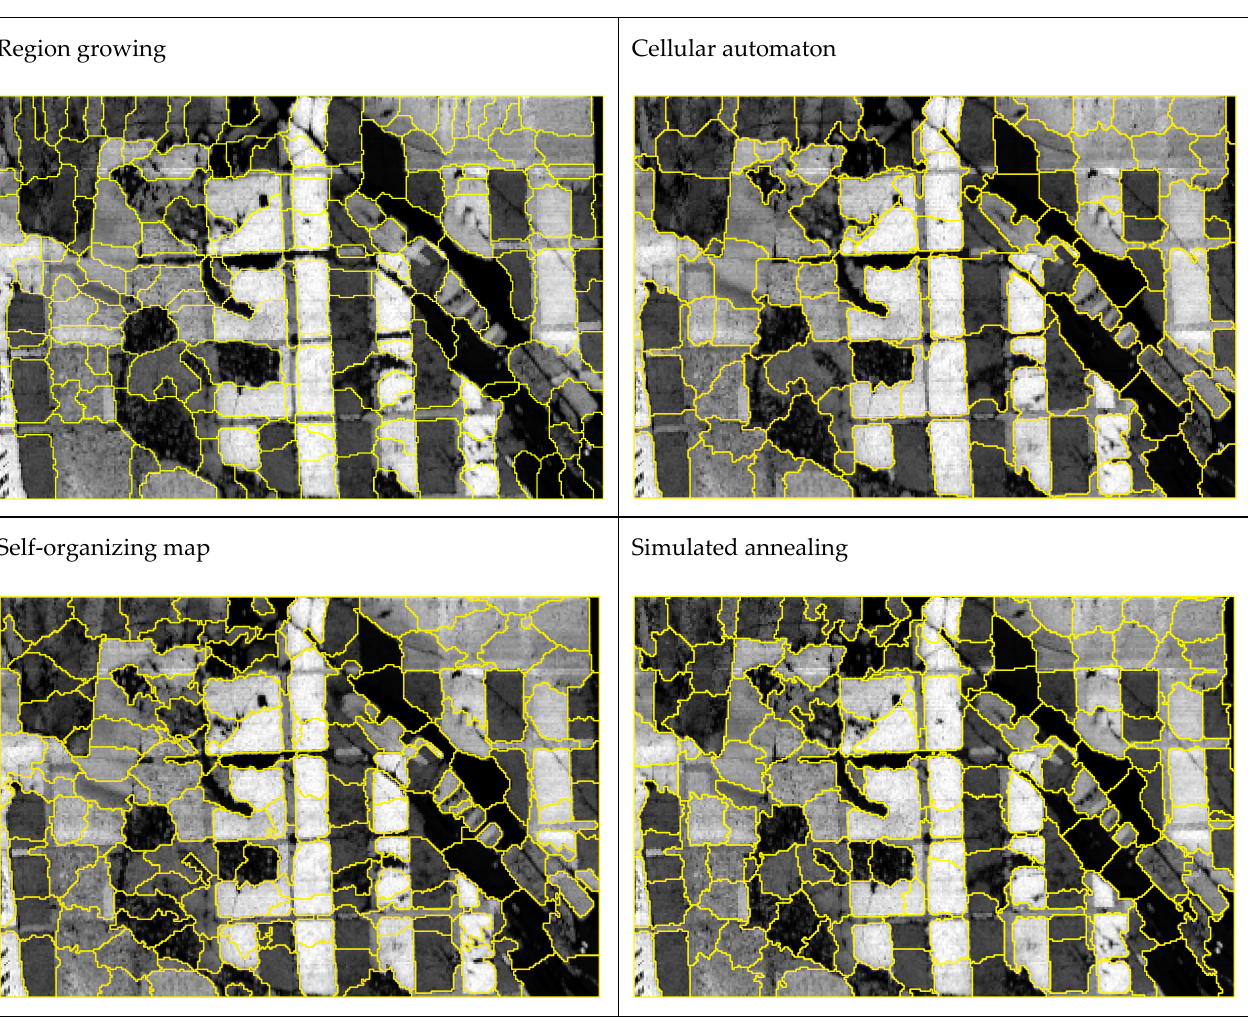
Figure 10. Segmentations produced by the four methods in case study area 2 (1.5 km × 1 km) overlaid with the 95th percentile of the height distribution of the echoes. Light tone indicates a high percentile value.